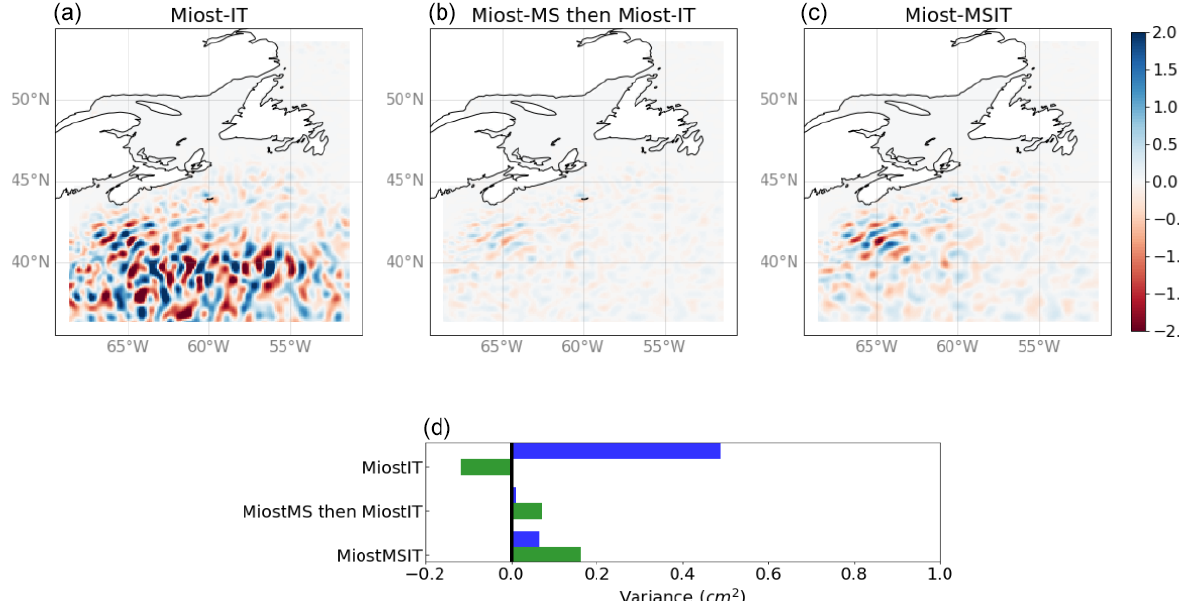
Figure 9. Same as Fig. 8 for the Gulf Stream